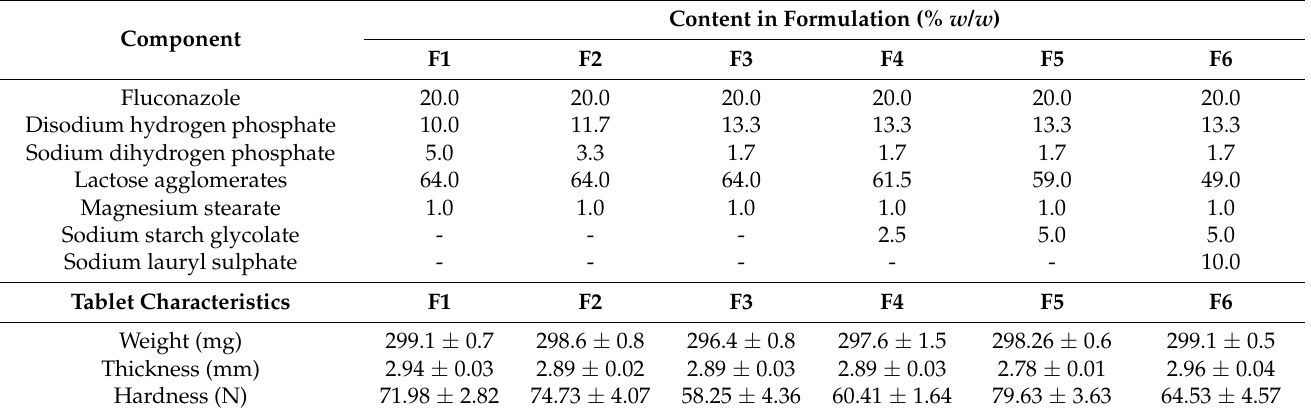
Table 2. Formulations and characteristics of fluconazole